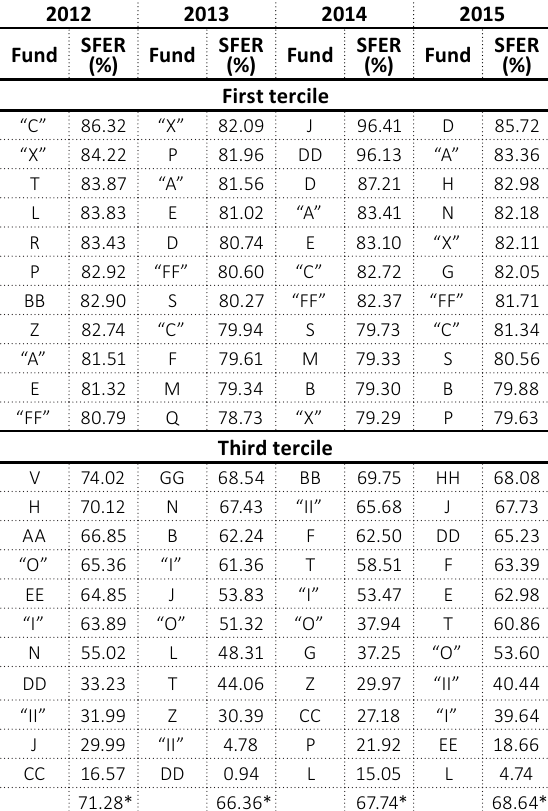
Table 3. Stochastic frontier efficiency rates